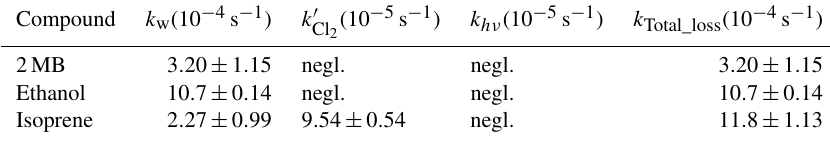
Table 1. Measured loss rate coefficients of 2MB and the reference compounds.